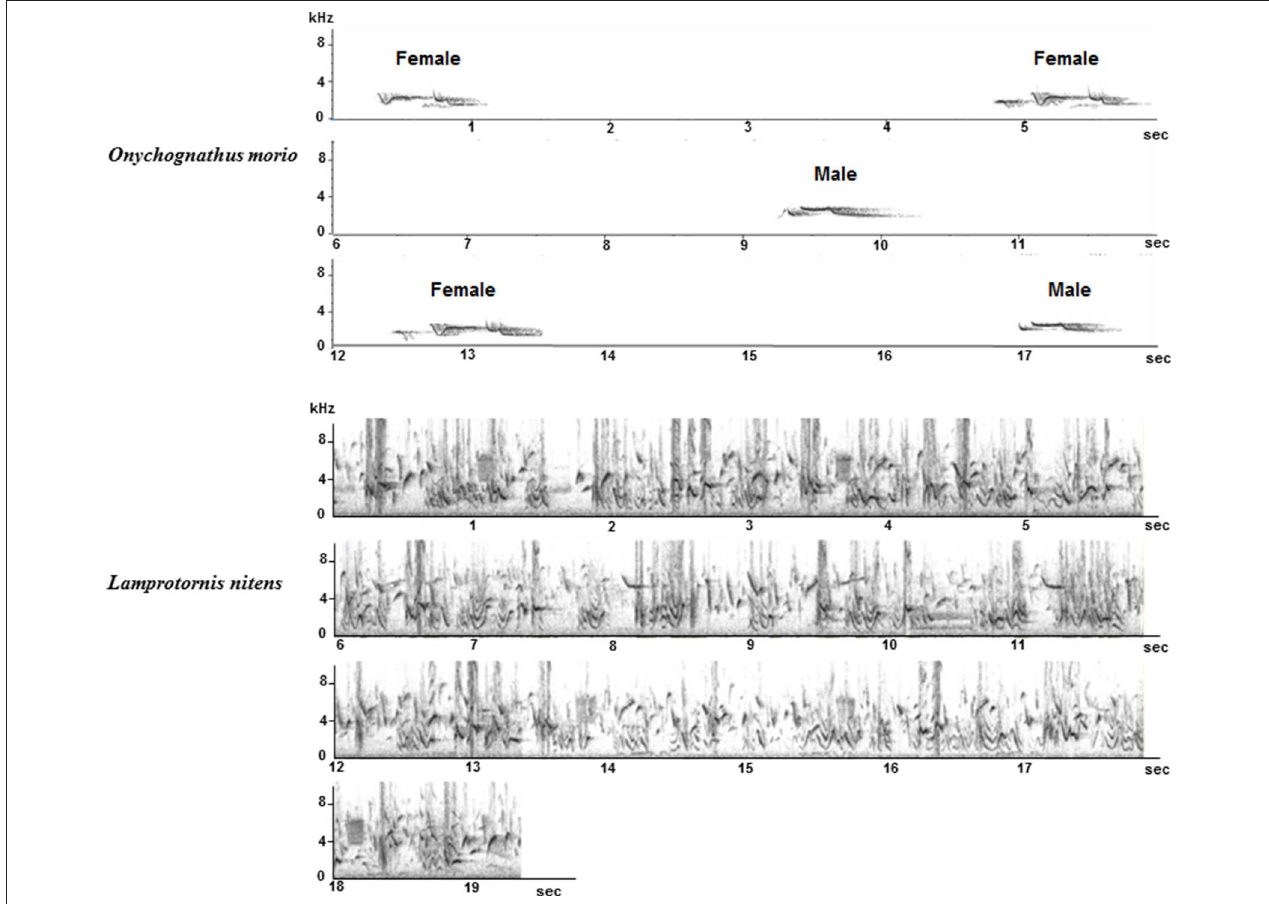
FIGURE 12 | Whistles of a male and a female O. morio (Top): whistles are separated by silent intervals. Chorus of L. nitens : several birds are singing together and songs overlap.